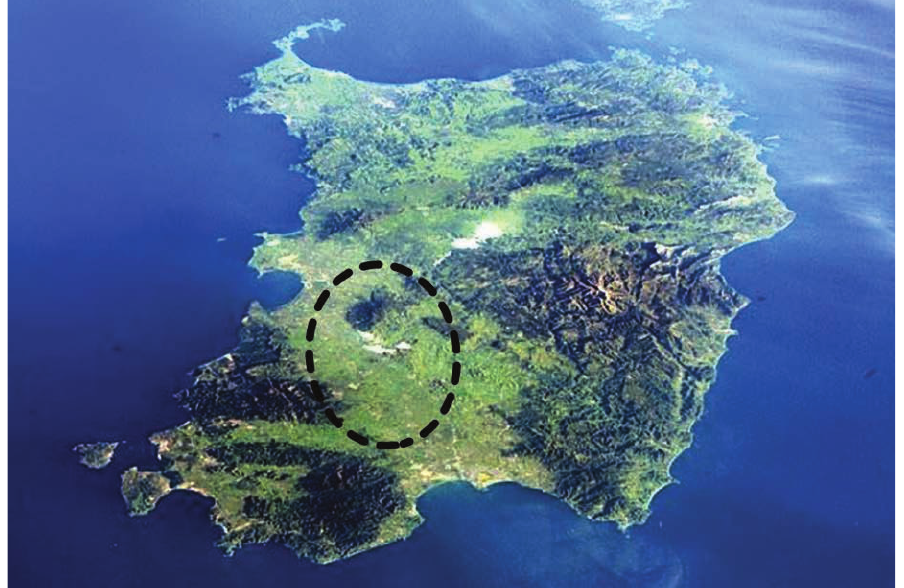
Table 1: Structure of the poetic contest